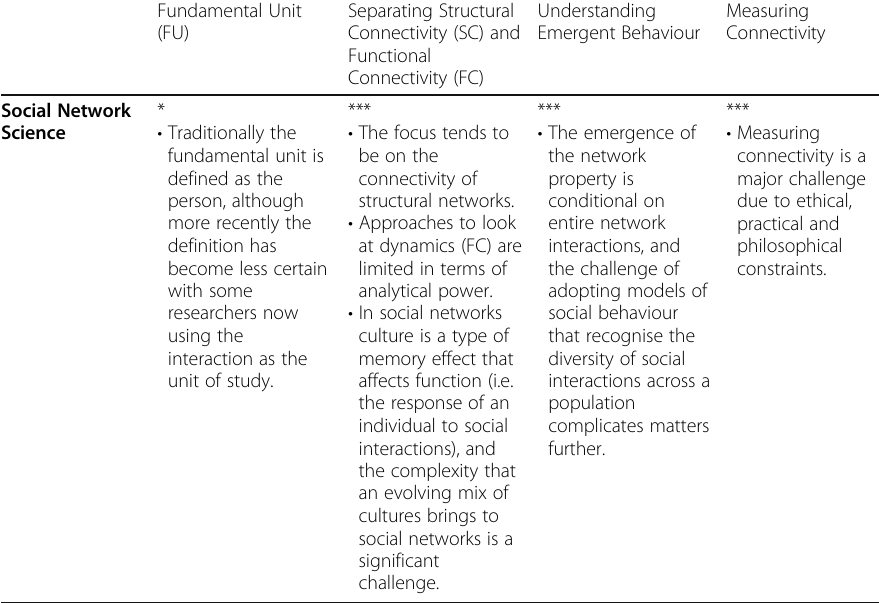
Table 1 Summary of connectivity challenges across different disciplines. Extent to which connectivity challenges are an issue: * do not present a challenge; ** presents a challenge but progress has been made; *** presents a major challenge.